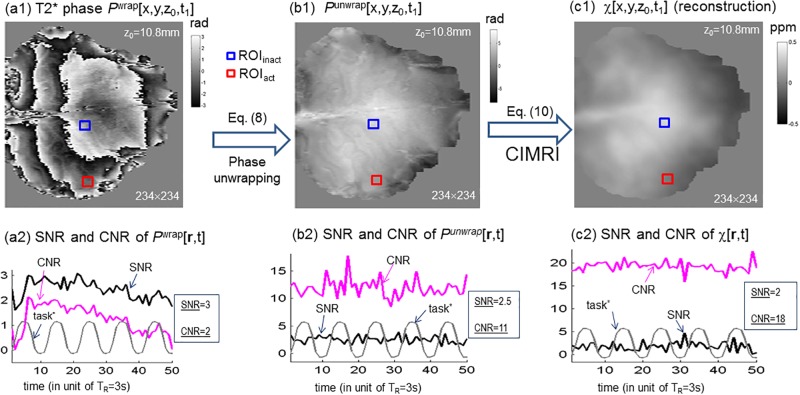
(a1,b1,c1) T2* phase processing and χ[r,t] reconstruction; (a2,b2,c2) SNR and CNR characterizations.The SNR CNR values were calculated according to the definition in Eq (14), with the ROIact and ROIinact defined retrospectively in Fig 5(c2), in a small size of 5 × 5 × 3 voxels. The task* is included to observe the dynamics of SNR and CNR with respect to the stimuli. The SNR and CNR denote time averages.